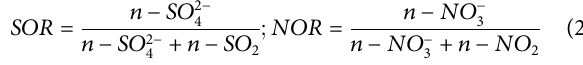
Frontiers in Environmental Science |